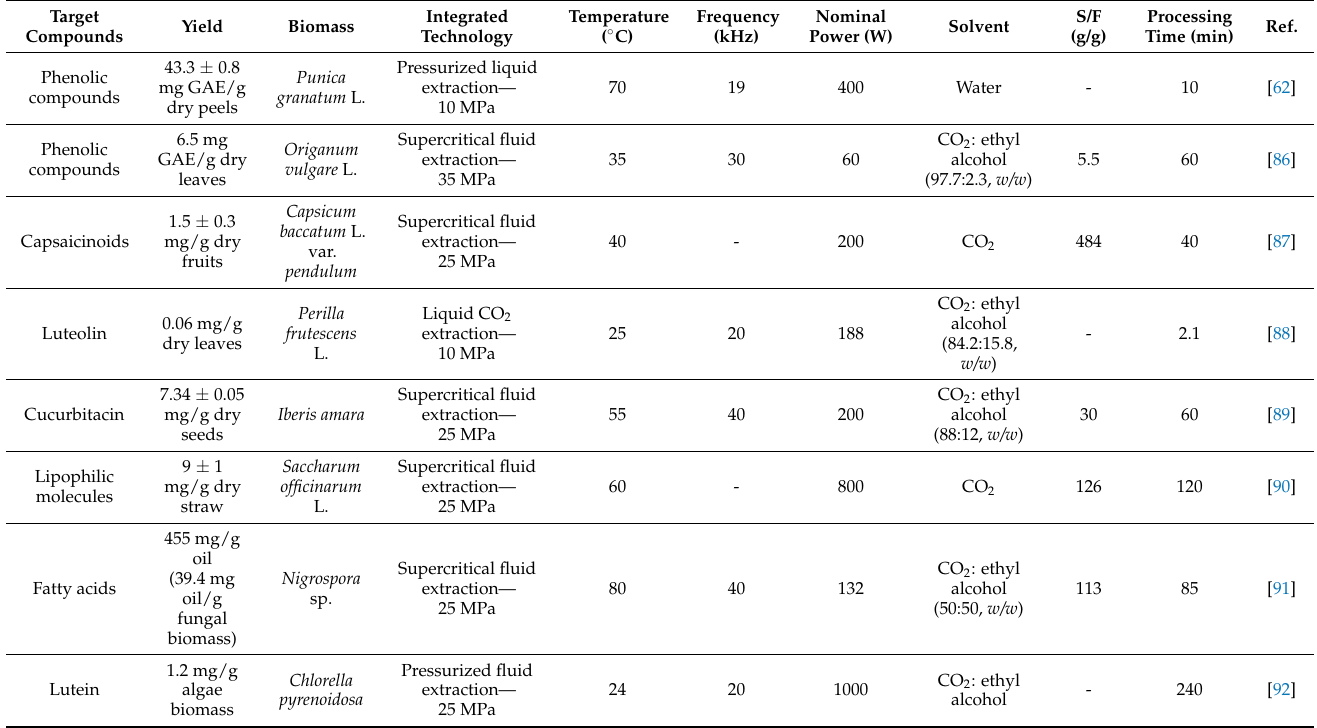
Table 2. Extraction of selected target compounds from different biomasses using ultrasound coupled to high-pressure